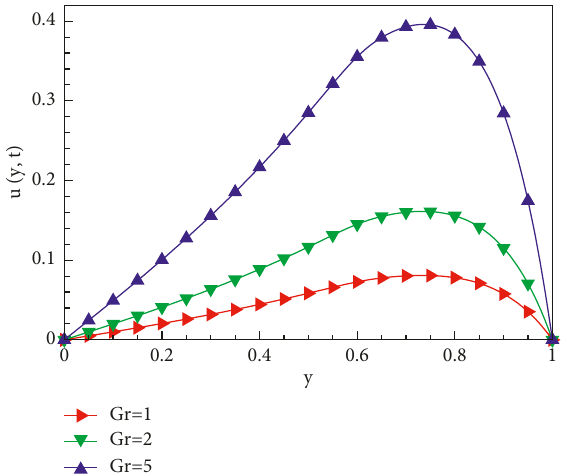
Figure 5: Influence of Gr on u when α � β � 1 , λ α